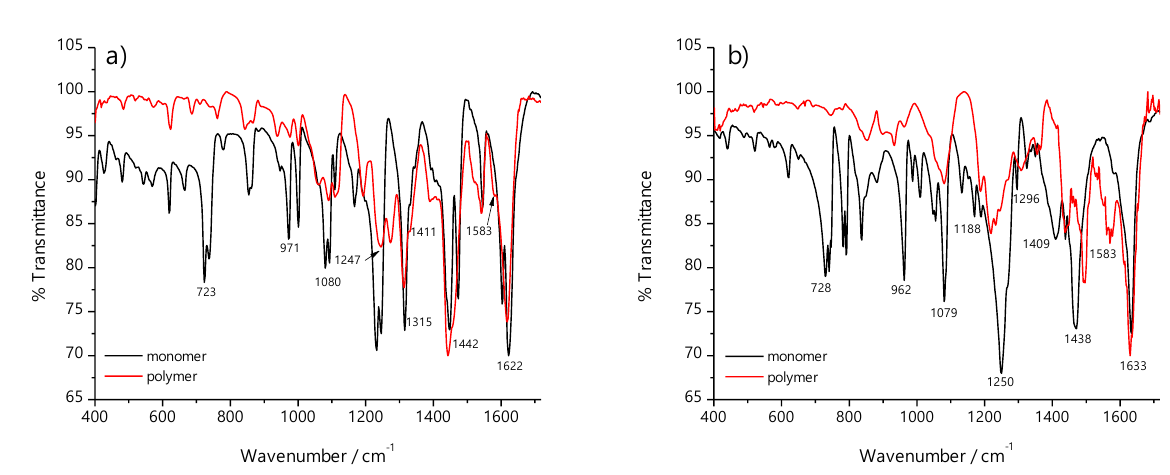
Figure 3. IR spectra of monomeric and polymeric nickel complexes poly-Ni(3-MeOSalen) ( a ) and monomeric and poly- meric ligands poly-H 2 (3-MeOSalen) ( b ).